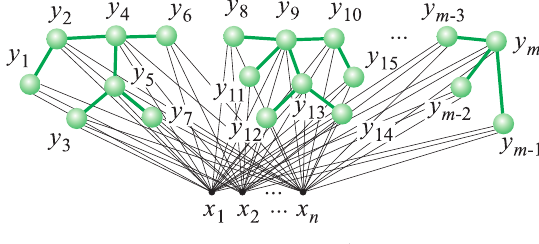
Figure 16. GeSOM with